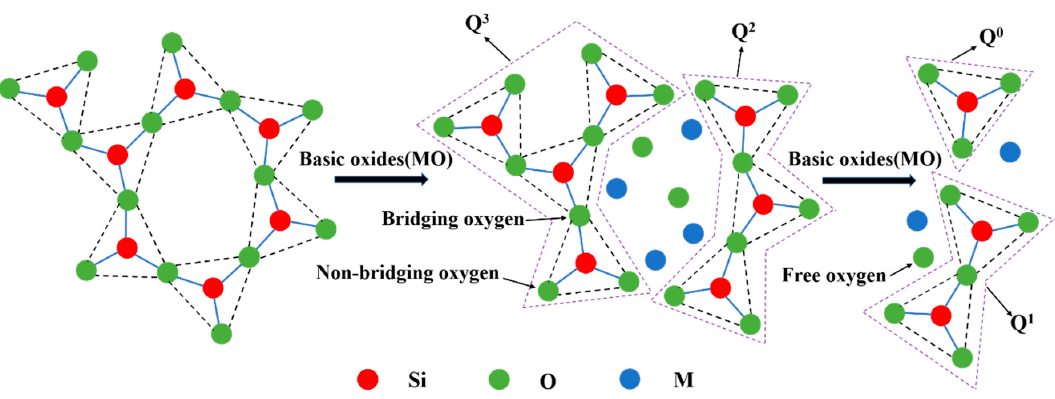
Figure 12. Schematic disintegration of the silicate structure by basic oxides.